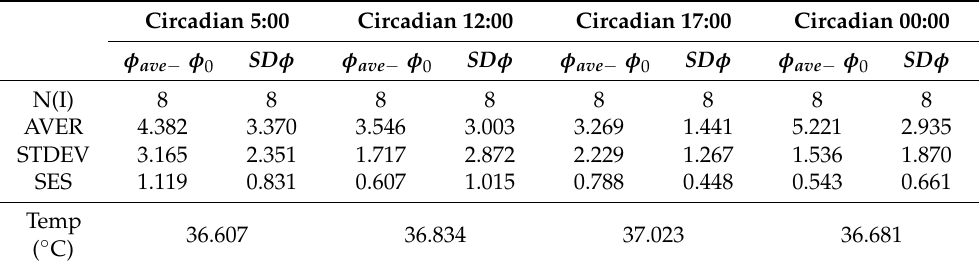
Figure 2. Tendency of the performance parameters in the normal circadian condition (P1–P4 = arbitrary number for assigning an order): φ ave − φ 0 ( rad ) = fixed-point shift, SD φ = variability as a function of the frequency competition with an arbitrary unit (a.u.) and density function (cumulative). Table 3. Averaged variables from the normal day–night temperature